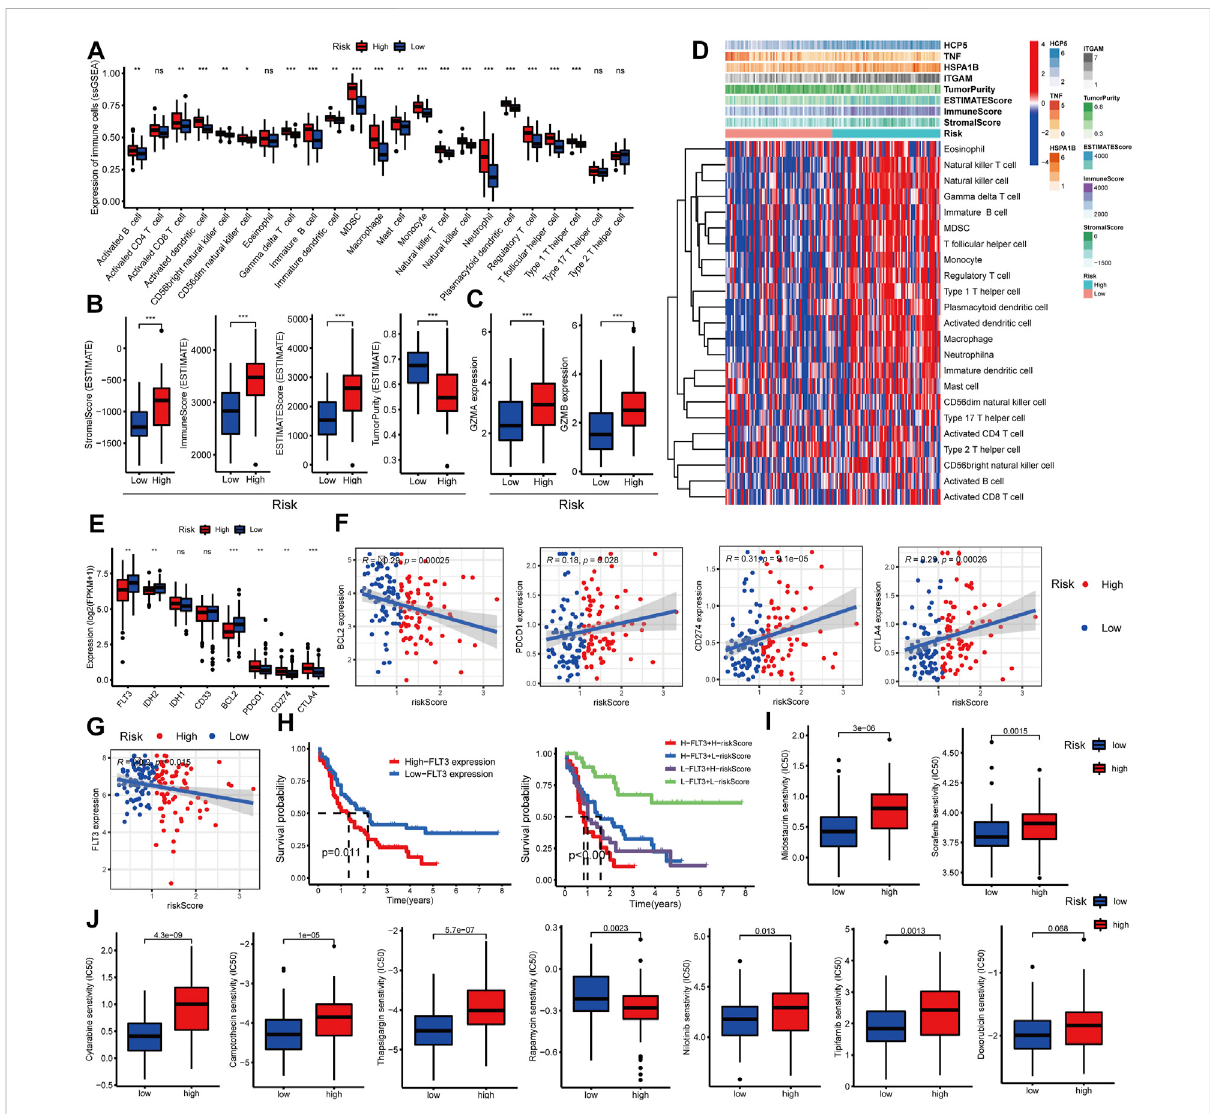
FIGURE 5 Evaluation of the relationship between the C-GPM and immune microenvironment. (A,B) Differences in common TIICs and the tumor microenvironment in the C-GPM were assessed, and the results indicated that patients in the high-risk group had a more pronounced immune or in fl ammatory activation phenotype. (C) Exploration of the difference between GZMA and GZMB that represents immune in fi ltration and immune cytolytic activity in theC-GPM. (D) Heatmapwas used to directly show thecorrelation between theC-GPM with four C-DEGsand the immune microenvironment. (E,F) Exploration of whether emerging therapeutic targets are differentially expressed in the two distinct groups of the C-GPM and analysis of their correlation with riskScore. (G) Analysis of the correlation between the novel therapeutic target (FLT3) and riskScore. (H) Survival analysis of FLT3 with or without riskScore. (I) Analysis of the effect of the C-GPM on the sensitivity of midostaurin and sorafenib that modulates the receptor tyrosine kinase FLT3. (J) Analysis of the effect of the C-GPM on the sensitivity of other common AML